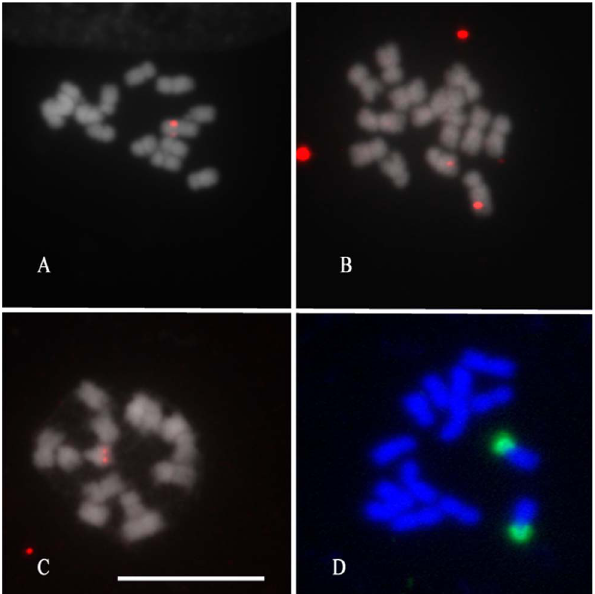
Fig. 1. Tyramide-FISH with indirect detection (A, B and C) and direct detection (D) systems on metaphase chromosomes of Rosawichurana . Chromosomes were hybridized with OOMT (A), P5CS (B), PAL (C) and pTA71 plasmid (D). (Bar - 10 m m).